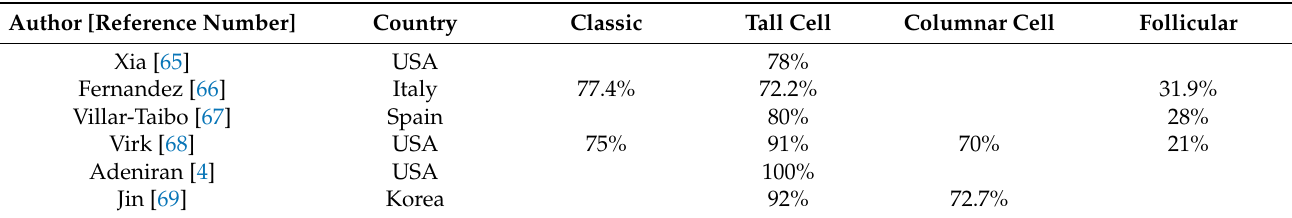
Table 1. Incidence of BRAFV600E mutation in PTC